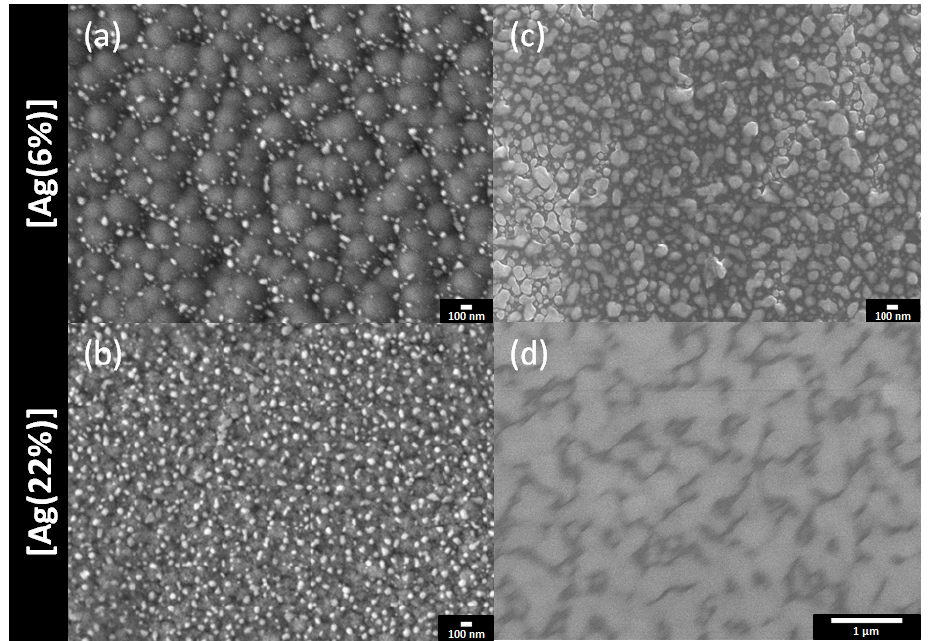
Figure 2. SEM surfaces images of a-C:H:Ag coatings: [Ag(6%)] on the top and [Ag(22%)] on the bottom. Top views of the coated samples directly after ( a , b ) and 1 year after ( c , d ) the deposition. Table 1. Particle-size distribution characteristics of the as deposited films. The same samples were re-examined after 1 year. The SEM images (Figure 2c,d) show that the surfaces are almost totally covered in silver, either as large particles or as a